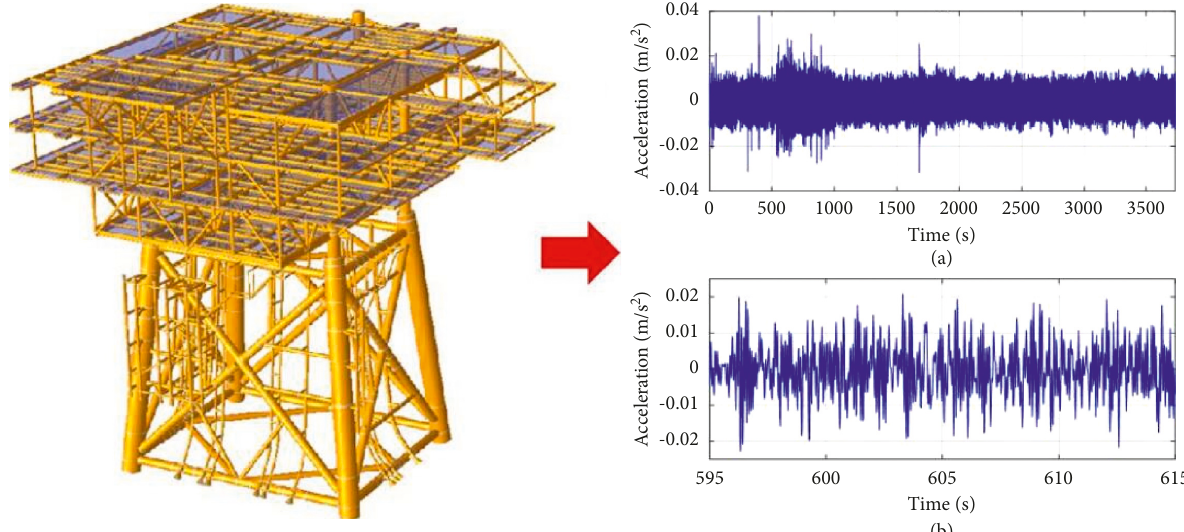
Figure 1: Measured vibrating signal of offshore substation: (a) model of offshore substation; (b) measured vibrating